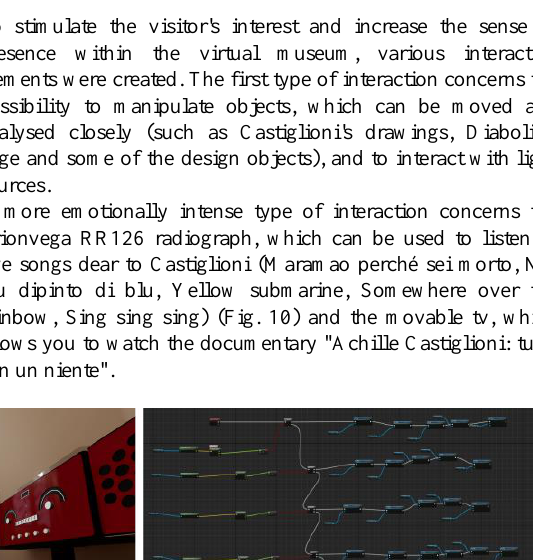
Figure 10. Blueprint of the Brionvega RR126 radiograph. The experience was enriched by some details that allow to get directly in touch with Castiglioni's personality: this is the case of the designer's glasses, placed on the Leonardo table in the Mirror Room, the box with the phrase "Prototipi Gibigiana", (which can be opened to extract the Gibigiana table lamp and a photo that shows the various stages of the prototype development), or the original recording of Castiglioni's whistle, which the user can listen to during the visit and which allows to perceive the designer's presence, as if his spirit continued to live in the virtual